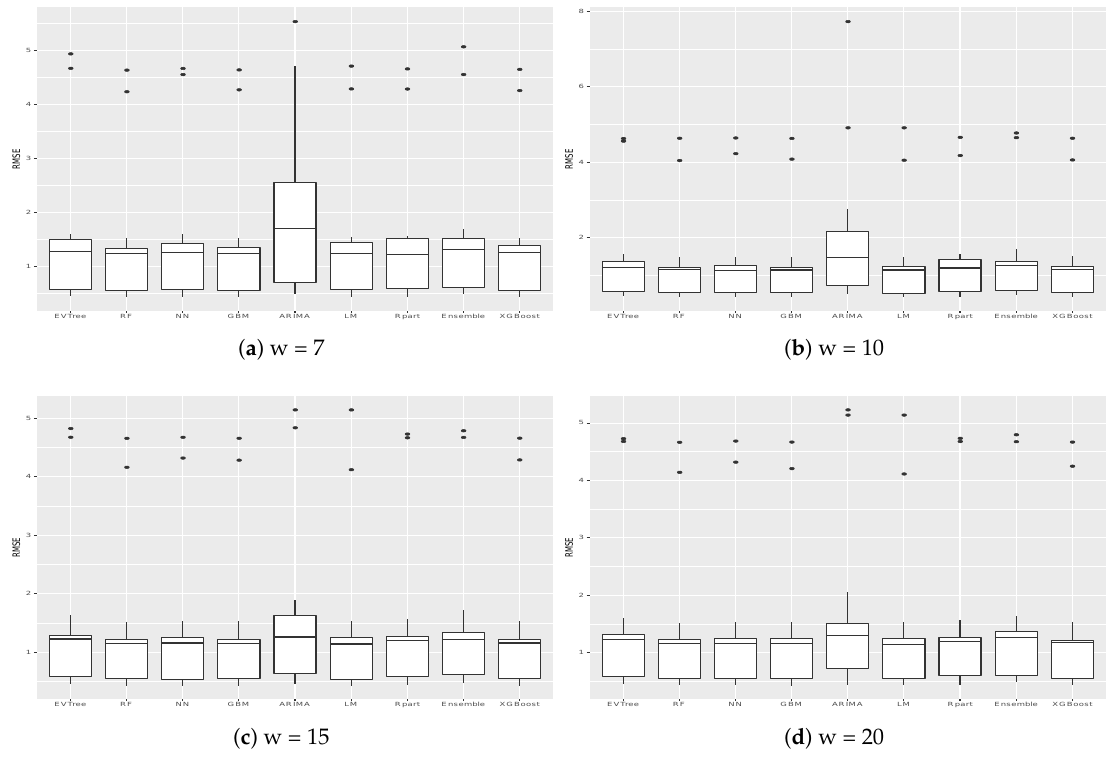
Figure 6. RMSE obtained on all the buildings for different values of the historical window w .